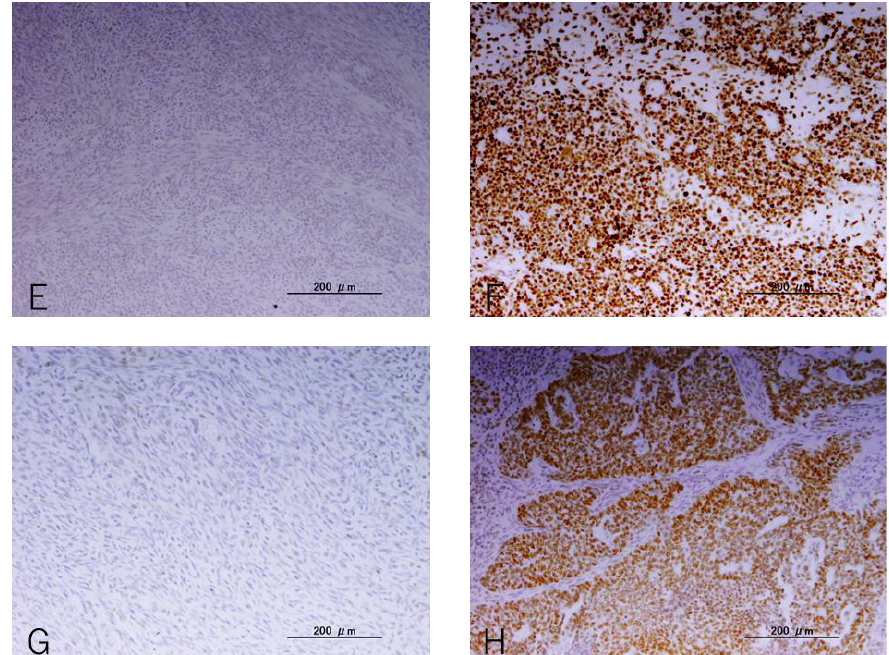
Figure 1. Representative images of immunostaining of MMR proteins in type II EC. ( A ) There is no expression of MLH1. ( B ) There is positive expression of MLH1. ( C ) There is no expression of MSH2. ( D ) There is positive expression of MSH2. ( E ) There is no expression of MSH6. ( F ) There is positive expression of MSH6. ( G ) There is no expression of PMS2. ( H ) There is positive expression of PMS2.